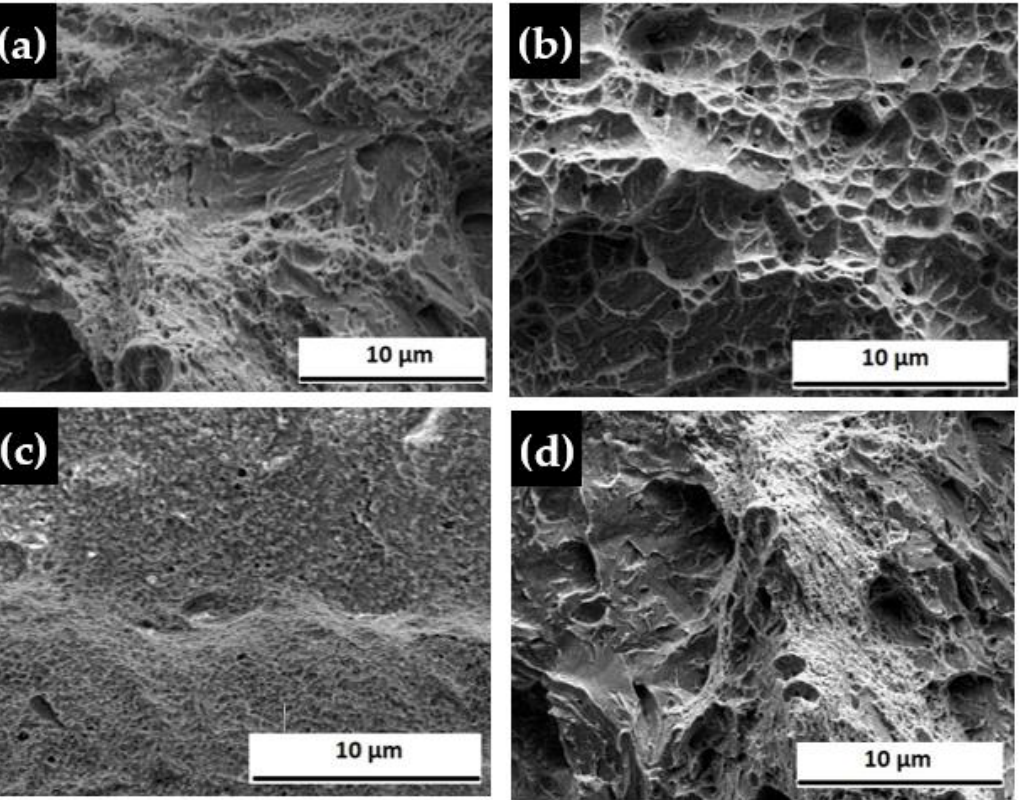
Figure 4. Fracture surface morphology for laser welded samples at different powers: ( a ) 500 W, ( b ) 550 W, ( c ) 600 W, and ( d ) 650 W.